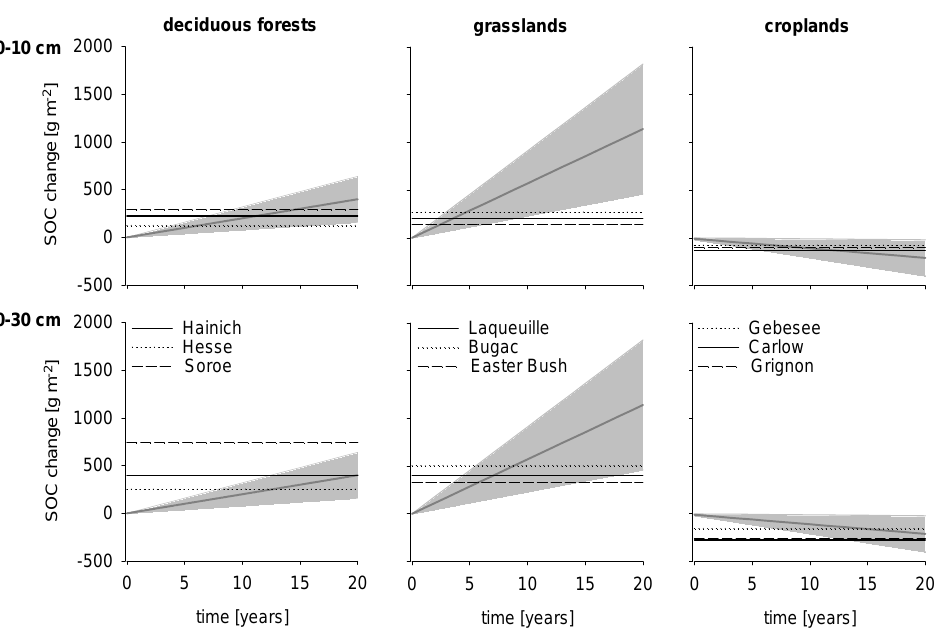
Fig. 8. Estimated linear changes in SOC with time based on values presented in Schulze et al. (2009) for different land use types ( ± standard deviation as grey shade). Horizontal lines present the minimum detectable difference of SOC stocks at individual sites for 0–10 and 0–30cm soil depth. The intersections between the curves indicate the time necessary to detect a change at the sites.